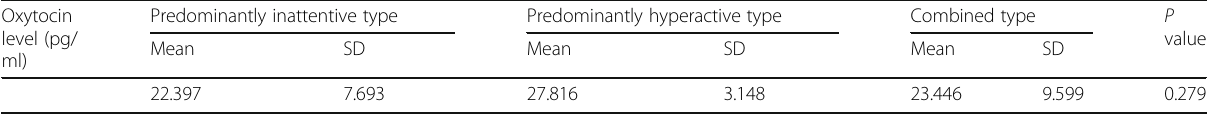
Table 2 Comparison of the mean salivary oxytocin level between subtypes of ADHD Oxytocin level (pg/